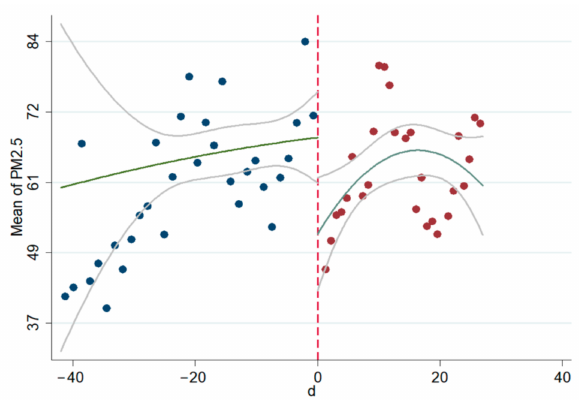
Figure 6. Scatter diagram of PM 2.5 before and after the interviews (nonlinear).